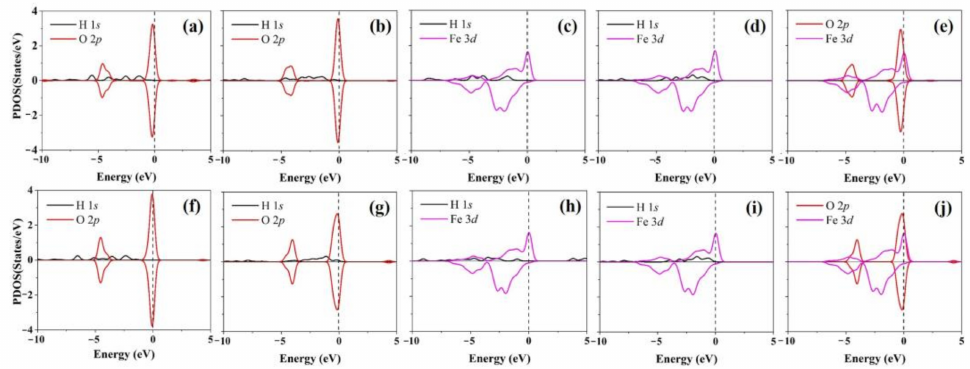
Figure 10. PDOS analysis of: ( a , f ) straight-chain aromatic hydrocarbon and Mg(OH) 2 ; ( b , g ) straight-chain paraffin and Mg(OH) 2 ; ( c , h ) straight-chain aromatic hydrocarbon and chal- copyrite; ( d , i ) straight-chain paraffin and chalcopyrite; ( e , j ) chalcopyrite and& Mg(OH) 2 . ( a – e ) Before adsorption; ( f , j ) after